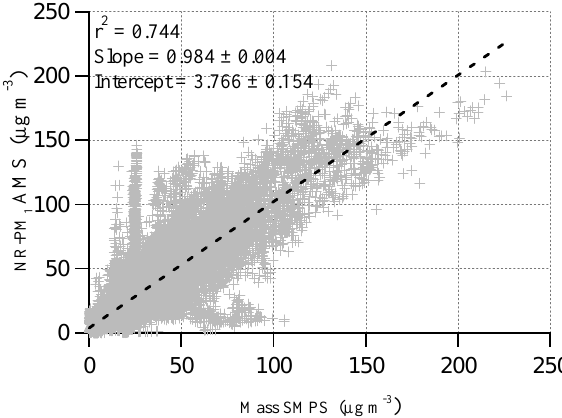
Figure 1. Correlation between AMS and (reconstructed) SMPS mass